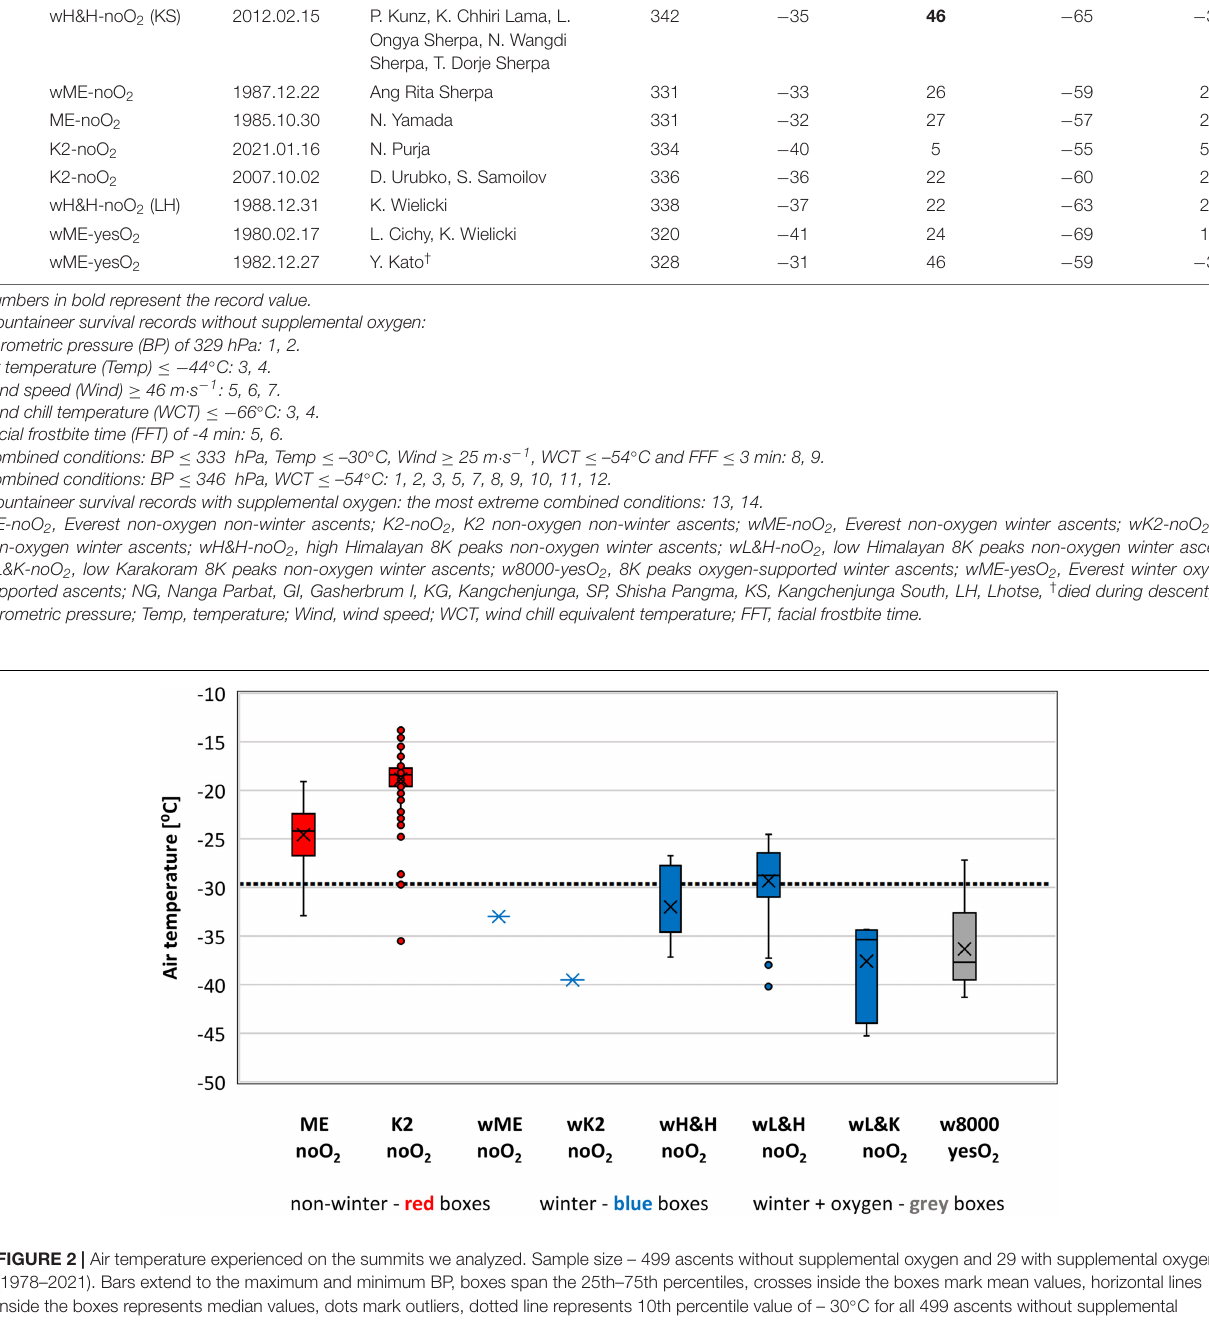
Frontiers in Physiology |